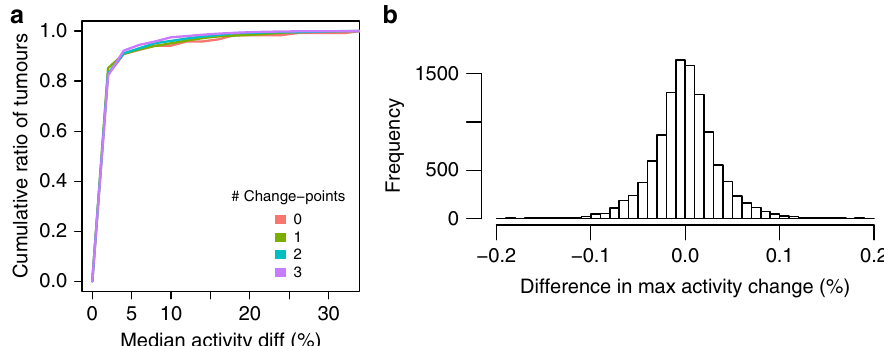
Fig. 2 Results on non-parametric simulations. a Median activity difference between the reconstructed trajectories and the ground truth. Lines correspond to the simulations with 0, 1, 2, or 3 changepoints. The median in computed across all signatures and time points in the sample. b Distribution of maximum activity change (MAC) discrepancies between between estimated activities and ground truth.